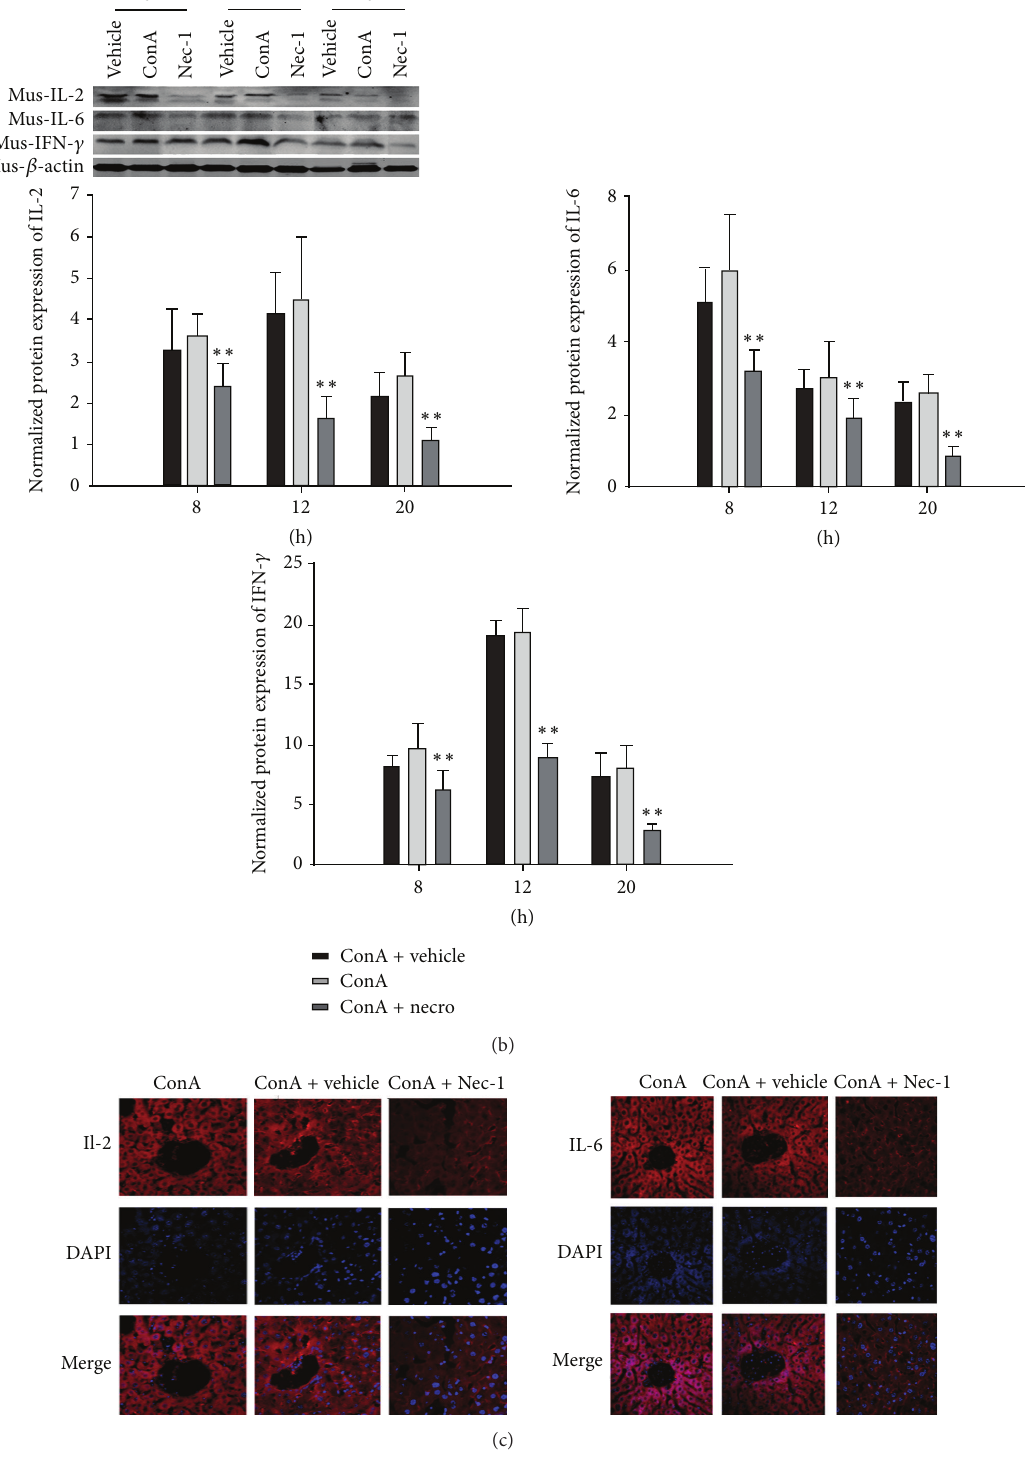
Figure 3: (a) ConA induced the release of cytokines in untreated (blank), negative-control-treated, and Nec-1-treated mice. IL2, IL4, IL6, IL10, TNF- 𝛼 , IFN- 𝛾 , and GAPDH mRNA expression in the livers of untreated (blank), negative-control-treated, and Nec-1-treated mice. IL2, IL6, IL10, TNF- 𝛼 , and IFN- 𝛾 mRNA expression in the livers of untreated (blank) and negative-control-treated groups were significantly increased after ConA injection compared with those in the Nec-1-treated mice. (b) Effects of Nec-1 on ConA-induced hepatic IFN- 𝛾 , IL2, and IL6 protein expression. (c) Localization of IL2 and IL6 in the liver tissues detected with immunofluorescence (original magnification × 200). These experiments were repeated three times, and representative results are